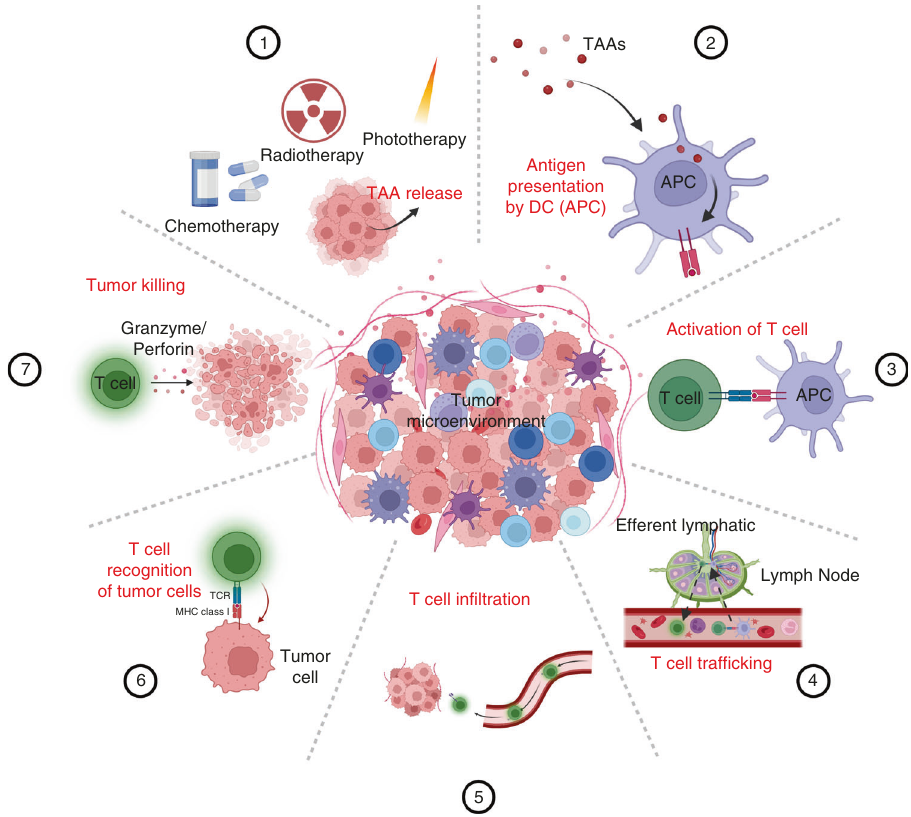
Fig. 4 Schematic illustration of the cancer immunity cycle, which can be divided into seven main steps: (1) release of TAA; (2) presentation of TAAs; (3) activation and proliferation of T lymphocytes; (4 − 5) traf fi cking and in fi ltration of T lymphocytes; (6) T lymphocyte recognition of cancer cells; and (7) killing of cancer cells by T